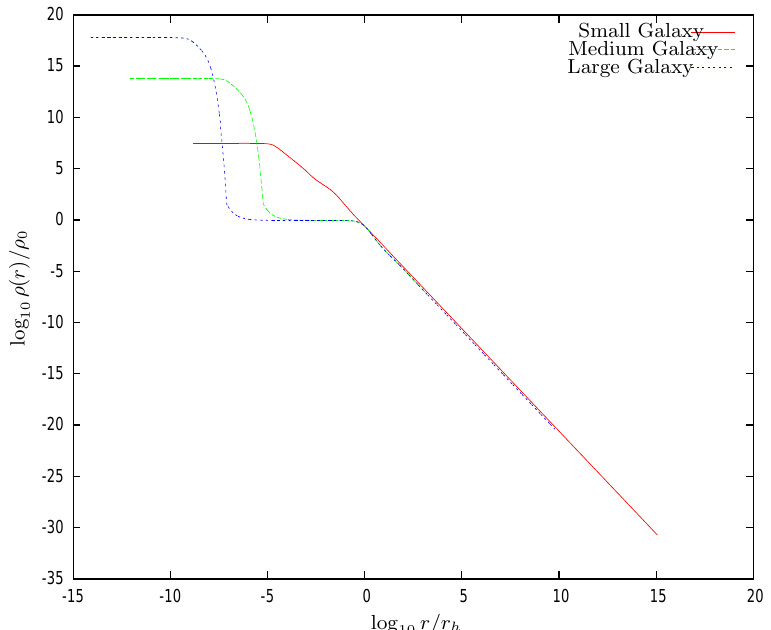
( ρ ( r ) / ρ 0 ) vs. log ( r / r h ) for the FIG. 3: The density ρ normalized at the influence radius r i , log ( ρ ( r ) /ρ 0 ) vs. log ( r/r h ) for the three galaxy solutions with Figure 3. The density ρ normalized at the influence radius r i , log 10 10 10 10 central SMBHs. Notice that in the quantum gas WDM region r < r A the density is constant clearly exhibiting a plateau three galaxy solutions with central SMBHs. Notice that in the quantum gas WDM region r < r A , the behaviour corresponding to the quantum Fermi gas behaviour in such region. density is constant clearly exhibiting a plateau behavior corresponding to the quantum Fermi gas behavior in such a region. than without the black hole. Notice that the small galaxy solution eq.(3.8) is just 11 % larger in halo mass than the minimal galaxy eq.(4.2) with central black hole.